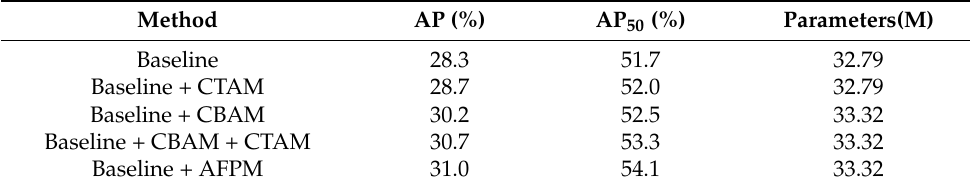
Table 4. Results of instance segmentation on the Cityscapes validation set.